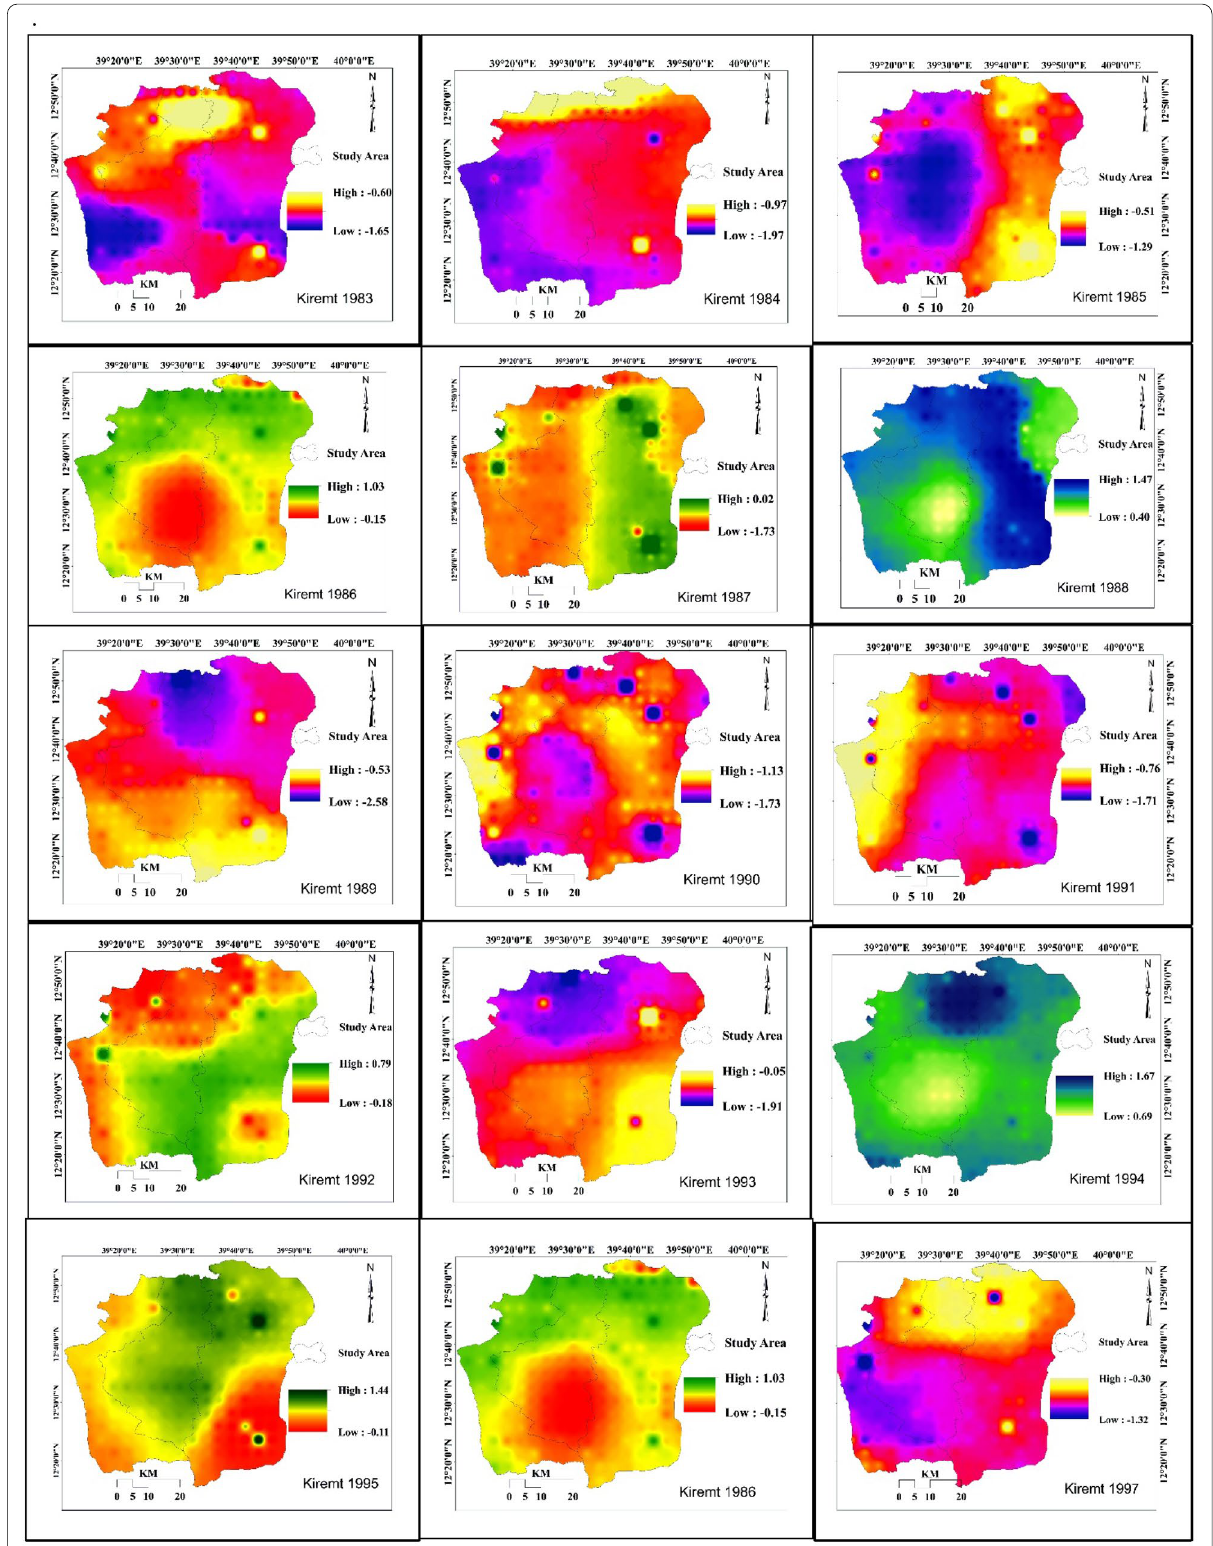
Fig. 7 SPEI3 spatial trends of drought and wet maps of Kiremt